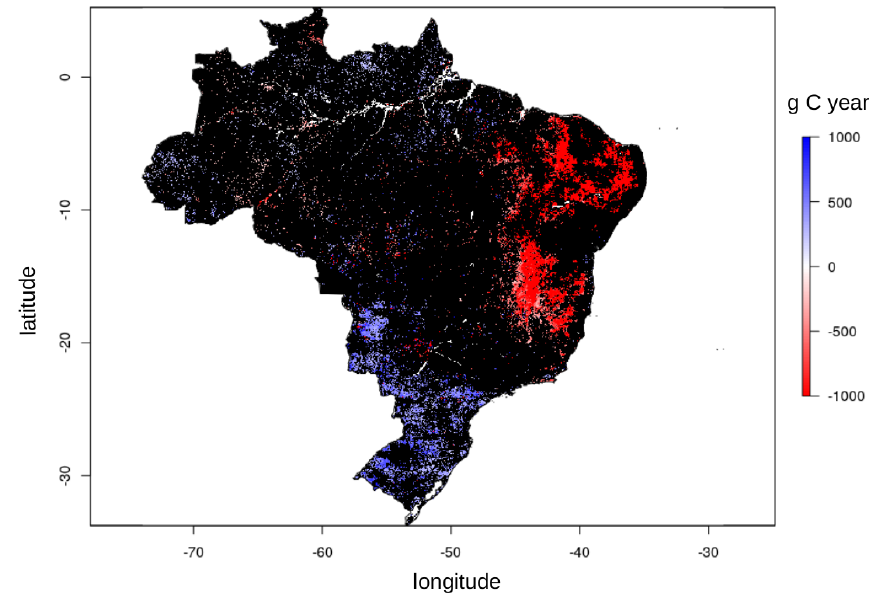
Figure 7. Trends of primary productivity of vegetation based on the GOSIF dataset between 2009 and 2015. Areas in black are non- significant.